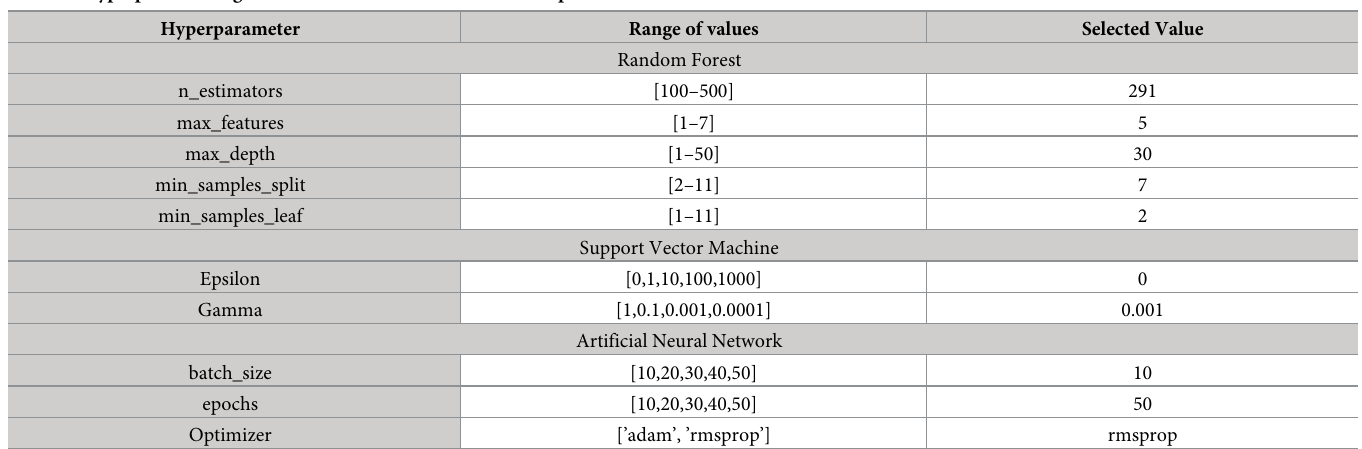
Table 5. Hyperparameters grid values and the selected values for optimized models.